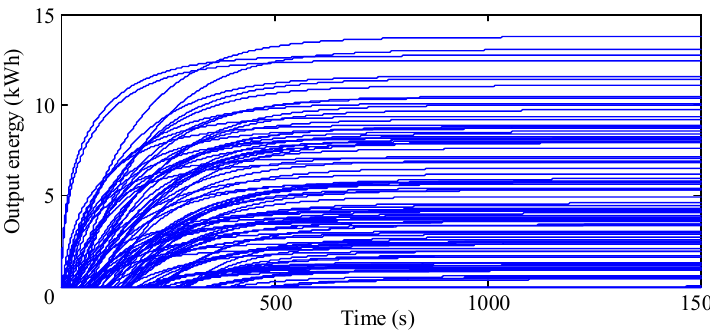
Figure 13. Curves of the output energy of each EV under the non-hierarchical control.